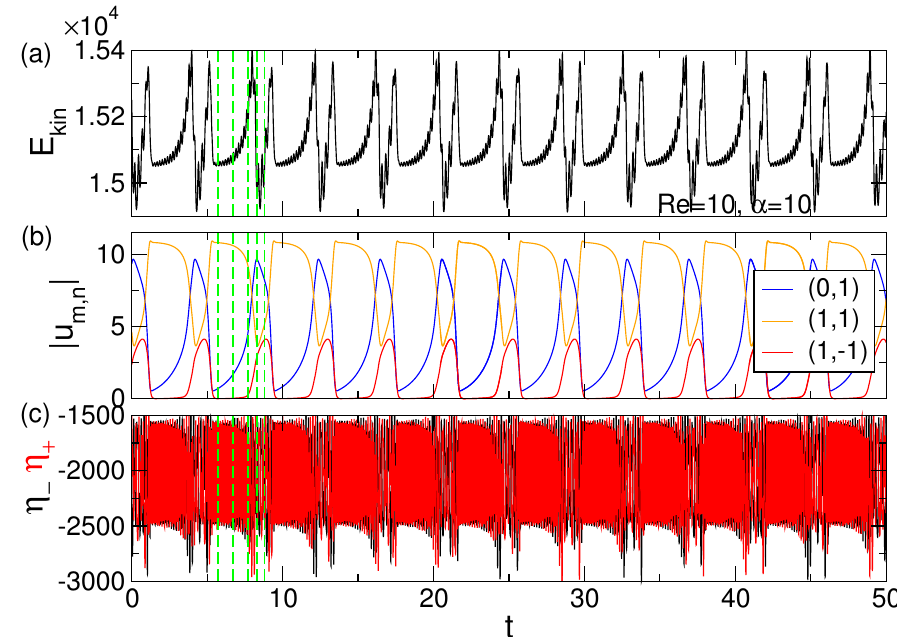
Figure 10. Time series of ( a ) kinetic energy E kin , ( b ) mode amplitudes | u m , n | of the dominant axial Fourier amplitudes of the azimuthal modes u m ( z , t ) (Equation (8)) of the radial flow at midgap, and ( c ) η ± illustrating the alternating transition scenario between the two unstable solutions 1-mwTVF and L1-wSPI, respectively. Control parameters Re = 10, α =